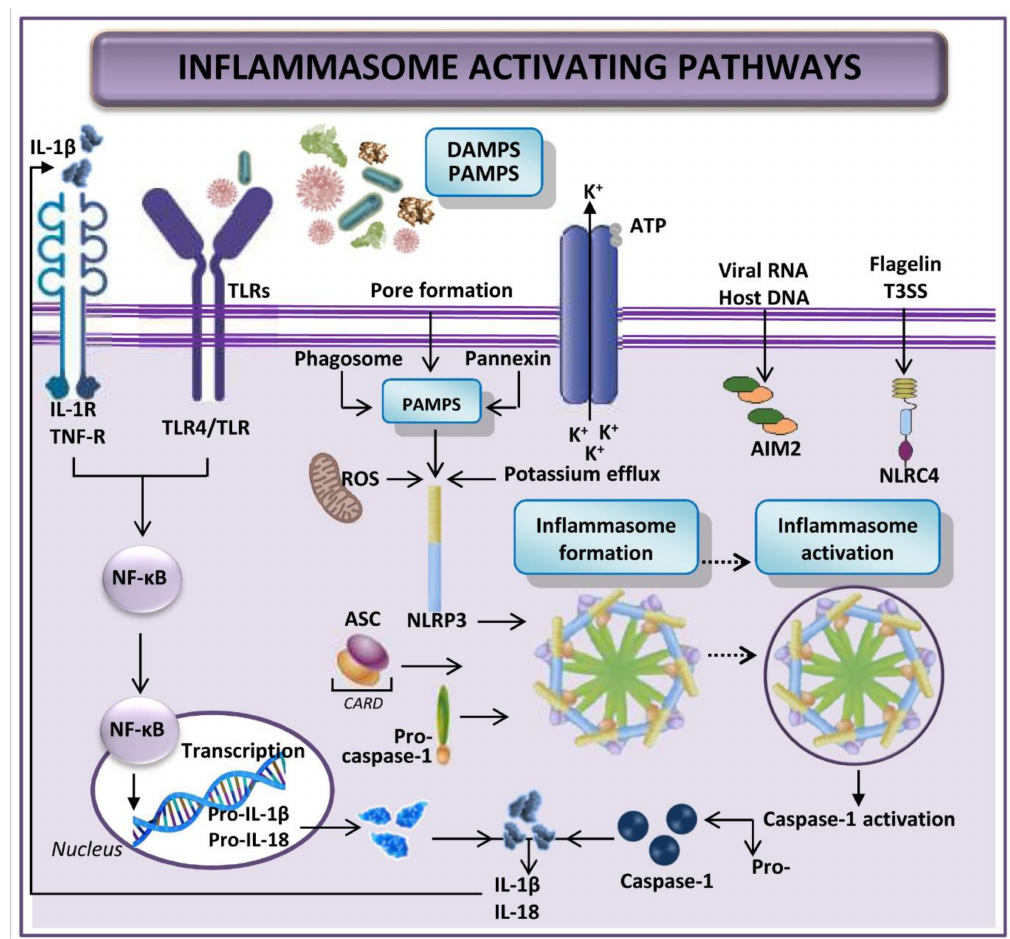
Figure 1. Schematic representation of the inflammasome activation pathways. Firstly, expression of inflammasome components is activated. Secondly, signaling by DAMPs and PAMPs results in the inflammasome activation, which entails pro-caspase-1 activation and cleavage of pro-IL-1 β and pro-IL-18 into their mature